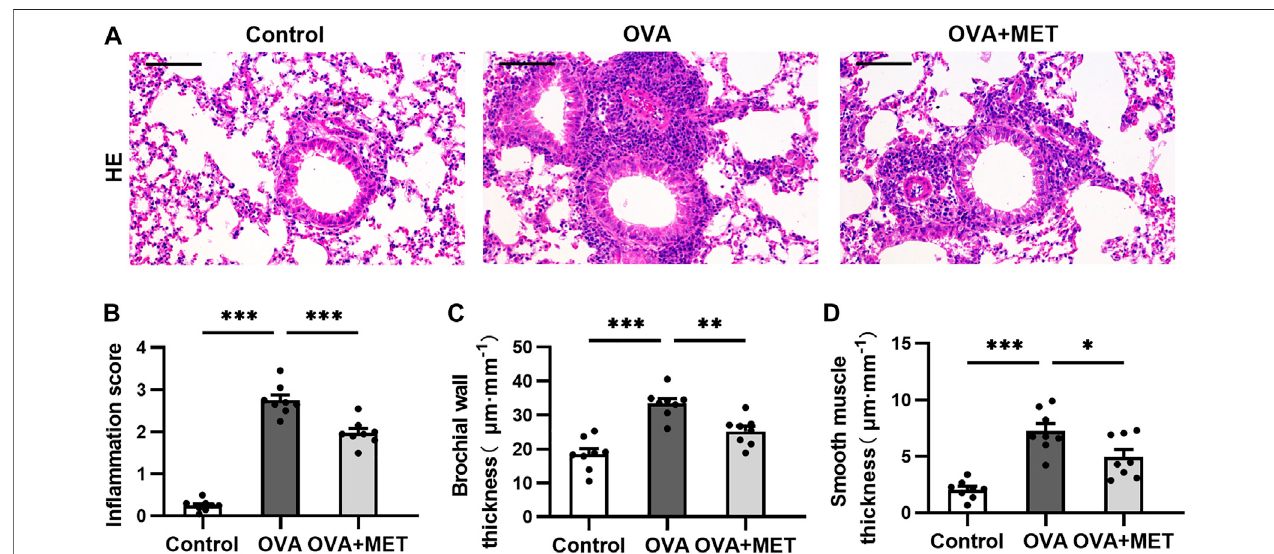
FIGURE 1 | Metformin inhibits in fl ammatory in fi ltration in lungs of OVA sensitized and challenged mice. (A) . Representative images of HE-stained lung tissue sections from each group. (B) . Blinded in fl ammation score evaluated from HE staining. (C,D) . Measurement of airway wall thicknesses and smooth muscle thicknesses from HE-stained lung sections by using Image-Pro Plus software. Data were presented as mean ± SEM ( n (cid:1) 8 animals, 20 bronchioles/3 sections of an animal, each bronchiole with 100 – 200 μ m of internal diameter). All images are at × 200 magni fi cation. Scale bar (cid:1) 100 μ m * p < 0.05, ** p < 0.01, *** p <